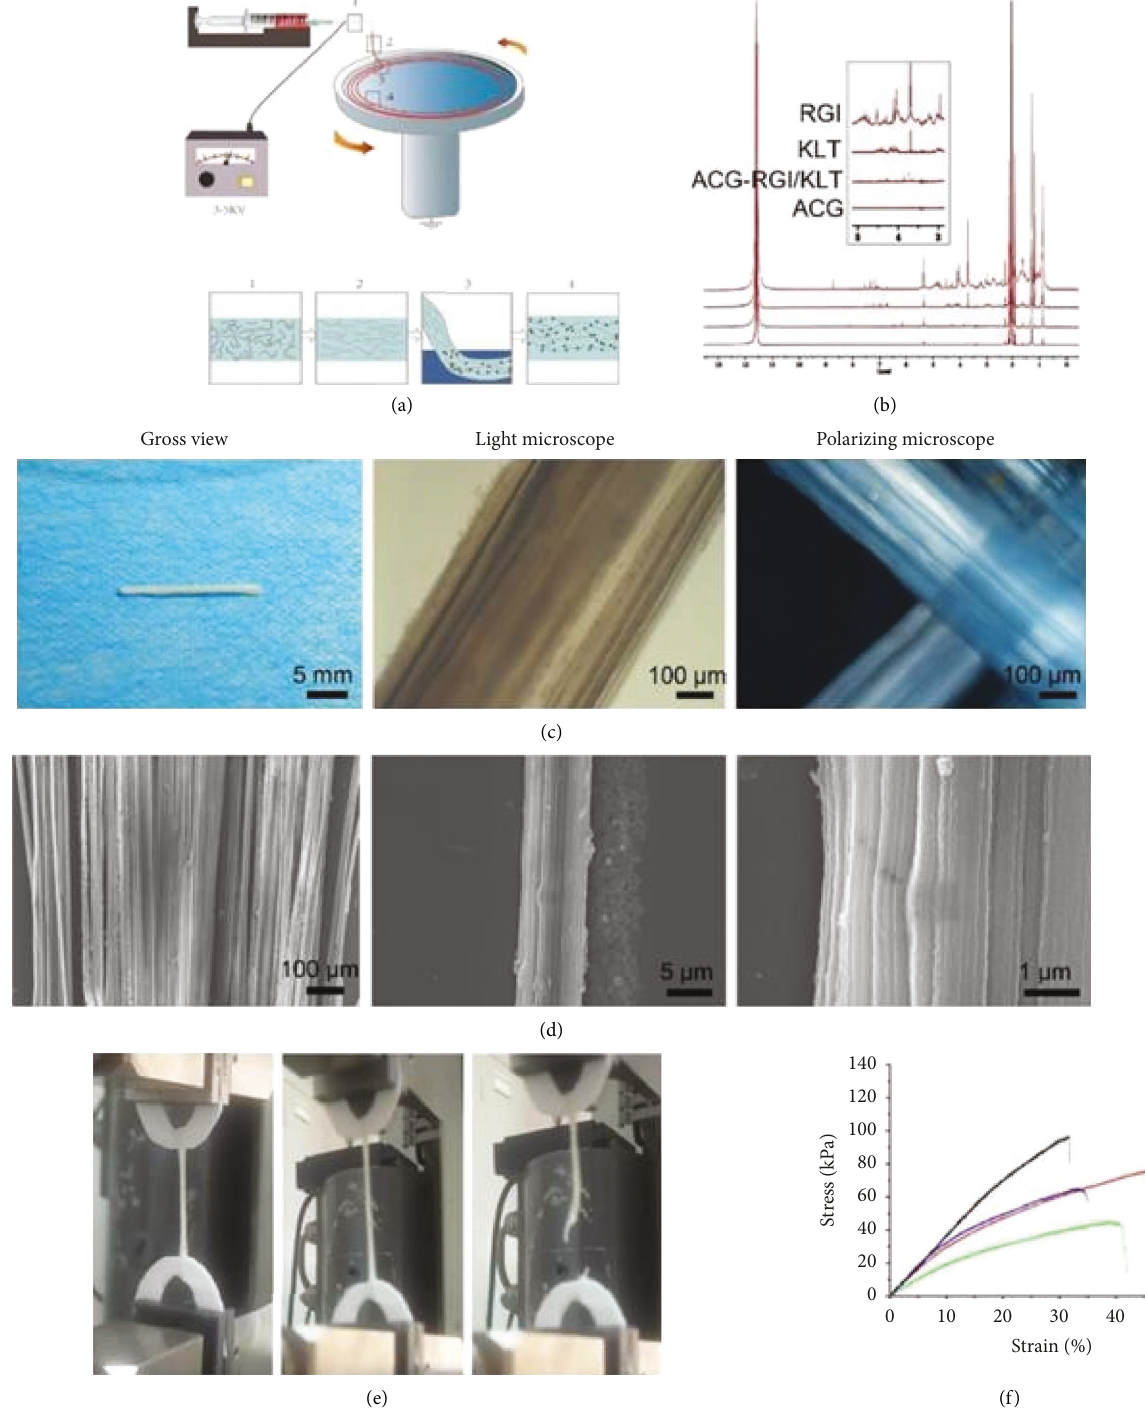
Figure 7: Preparation and characteristics of aligned chitosan fiber hydrogel. (a) Illustration of the electrospinning and mechanical stretching setup. A voltage of 3–5 kV was applied between the spinning solution and collector. Chitosan polymer chains became increasingly aligned as the chitosan hydrogel was extruded from the needle (box 1) and stretched during entry (box 2) into a rotating bath. As the chitosan hydrogel entered the rotating bath (box 3) containing sodium tripolyphosphate (STPP; black dots) under mechanical stretching, chitosan chains were further aligned and crosslinked by STPP in the bath (box 4), thus forming a stable chitosan nanofiber hydrogel. (b) Proton nuclear magnetic resonance (NMR) spectroscopy of RGI and KLT. (c) Gross view and light microscopic images of an aligned chitosan hydrogel bundle. Polarized light microscopic images show optical extinction in the crossover region of two chitosan fiber bundles. (d) Scanning electron microscopy (SEM) images of aligned chitosan fiber hydrogel (ACG) showing hierarchically aligned structures under different magnifications. (e) Test of the mechanical properties of aligned chitosan hydrogels. (f) Elastic modulus of aligned chitosan hydrogels; reprinted with permission under open access by Rao et al.